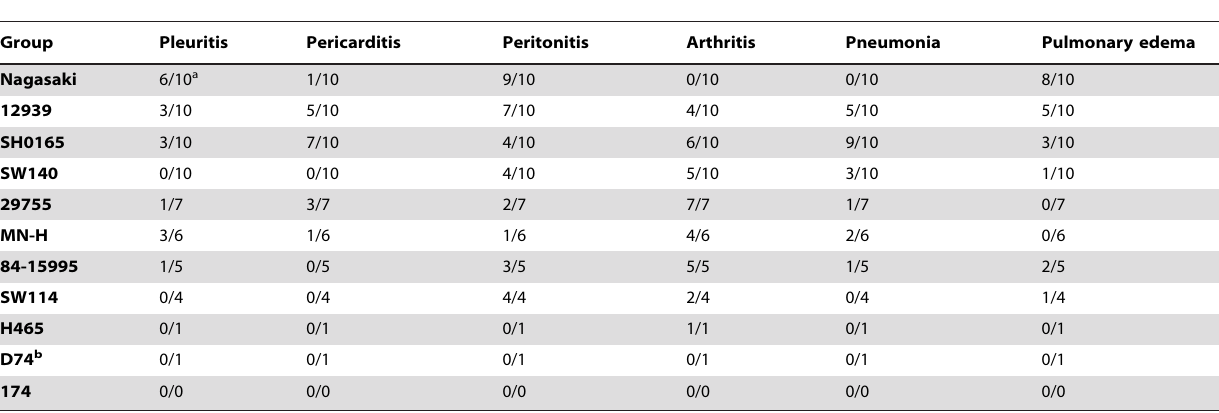
Table 6. Frequency of gross lesions in H. parasuis infected pigs that died or were euthanized after demonstrating clinical signs consistent with Gla¨sser’s